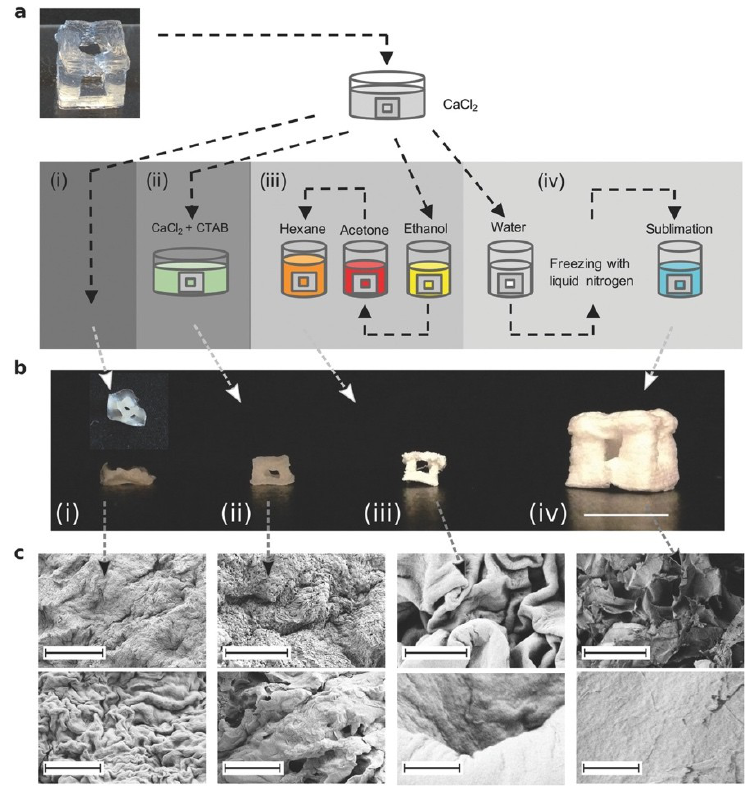
Figure 6. Depiction of the DIW of CNF aerogels ( a ) and four different methods of drying ( b ). From left to right, the CNF hydrogel drying procedures are (i) air drying), (ii) air drying in the presence of surfactants, (iii) solvent exchange before drying, and (iv) freeze-drying. ( c ) SEM micrographs of the resulting microstructures of such dried CNF aerogels. Adapted from [92] with permission, copyright John Wiley & Sons, 2016.